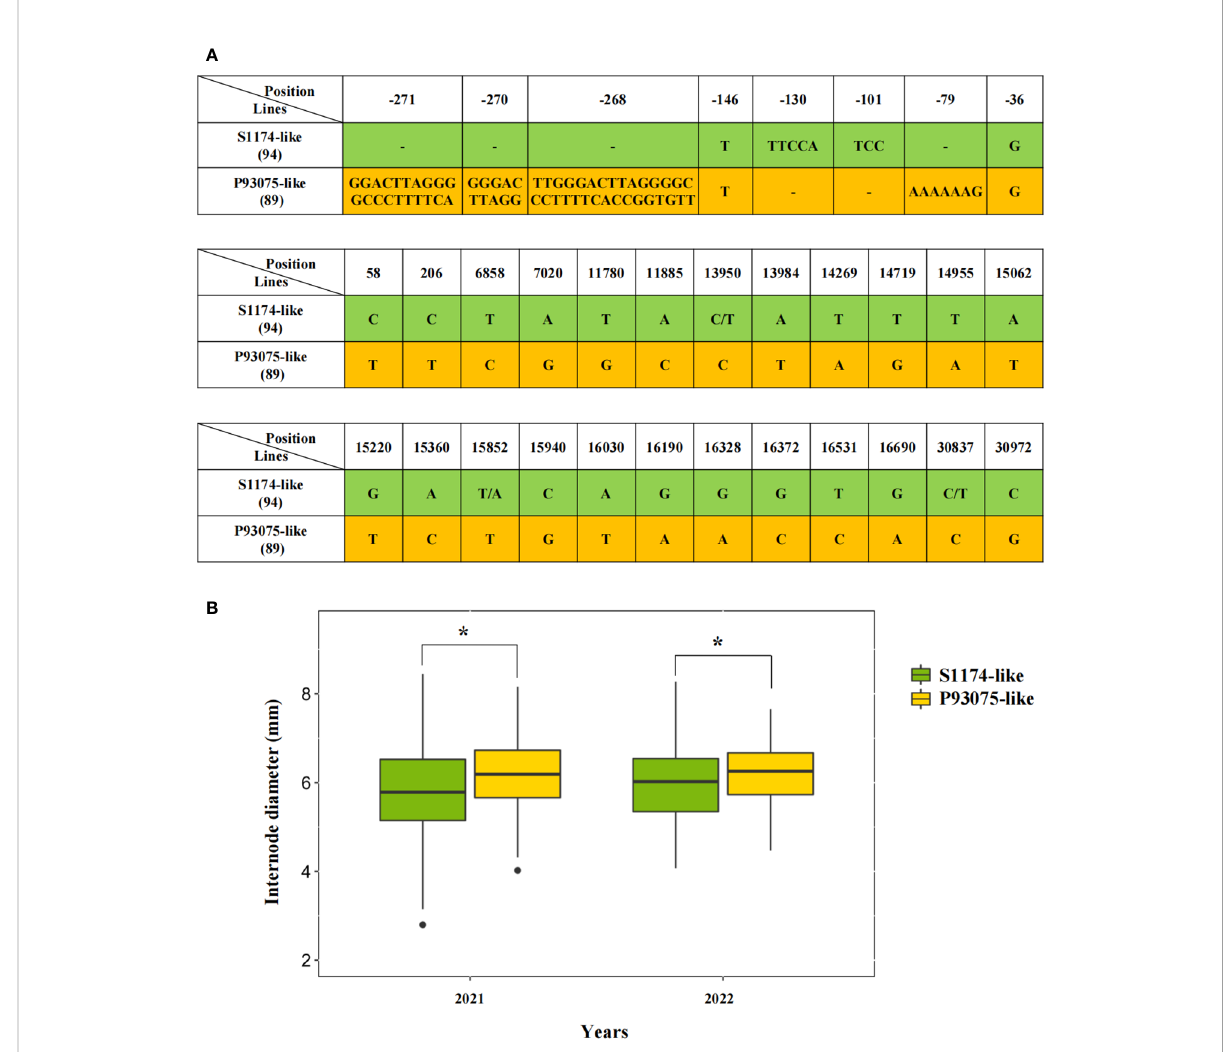
FIGURE 4 Haplotype analysis of LacCRWN3 among the 183 core inbred line population. (A) Distribution of the nonsynonymous mutation single nucleotide polymorphisms (SNPs) in exons and variations in 5 ’ un-translated region (UTR) for the two haplotypes of S1174-like and P93075-like. The fi gures in parentheses denote the number of inbred lines belonging to the corresponding haplotypes. The two haplotypes are displayed in green and yellow backgrounds, respectively. (B) The average internode diameter differences between the two haplotypes in the 2021 and 2022 seasons. Results indicate mean ± SE of three replicates, * P <